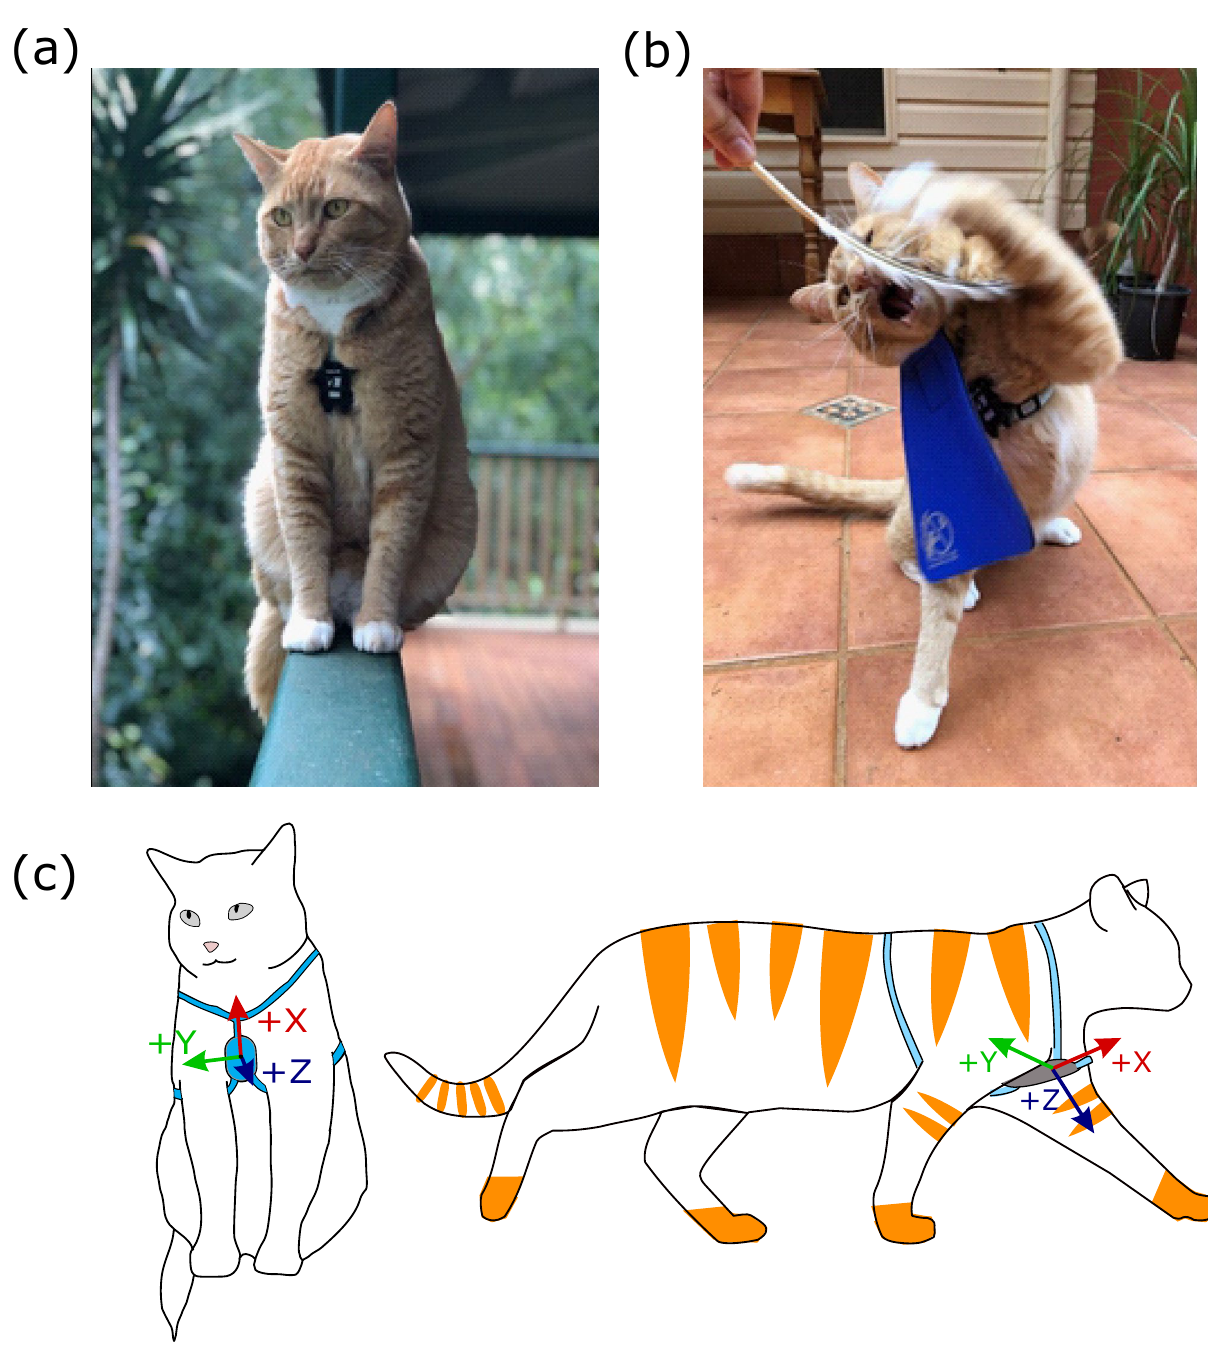
Figure 1. ( a ) The anatomical position of the accelerometer (AX3) on the sternum of the cat. ( b ) The activity of swatting stimulated by the use of a feather. ( c ) The axis orientation of the accelerometer planes, which are represented in the accelerometer trace data in the MATLAB interface. Fore-aft (surge), lateral (sway) and dorso- ventral (heave) movement is reflected in the X, Y and Z